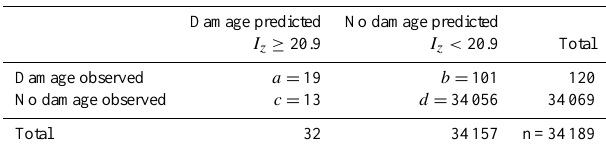
Table 7. Contingency table, cutoff point θ = 0 . 5 ( α = 1 × 10 − 5 , z = 60, property